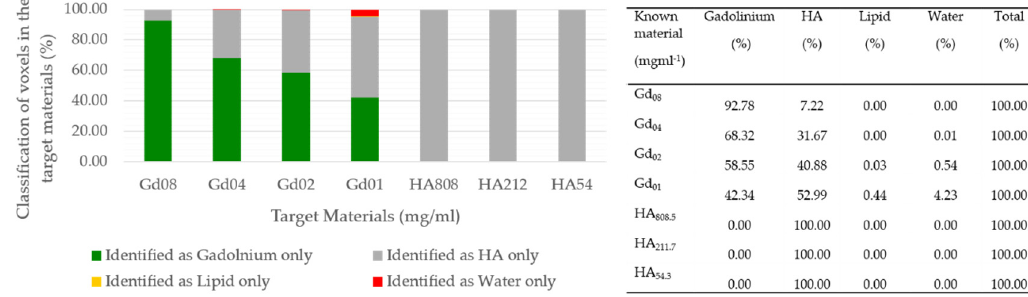
Figure 11. MD identification chart for protocol ‐ 2 shows quantitative misidentification of voxels between gadolinium, hydroxyapatite, lipid and water. For given gadolinium solutions, sensitivity decreased from ~94% for 8 mg Gd/mL to 42% for 1 mg Gd/mL solution insert. For HA, no misidentification was observed in any of the given calibration rods. A corresponding table in the right is shown to look up individual value in the chart.